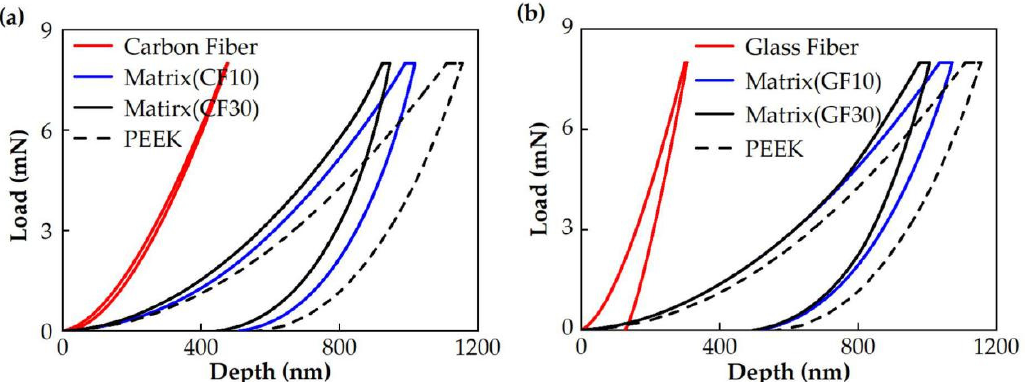
Figure 2. Load–depth ( P – h ) curves for ( a ) carbon-fiber-reinforced PEEK (CF/PEEK) materials and ( b ) glass-fiber-reinforced PEEK (GF/PEEK) materials from the nanoindentation tests with a maximum load of 8 mN. The P – h curves of the pure PEEK, the carbon fiber, and the glass fiber are displayed for comparative analysis.